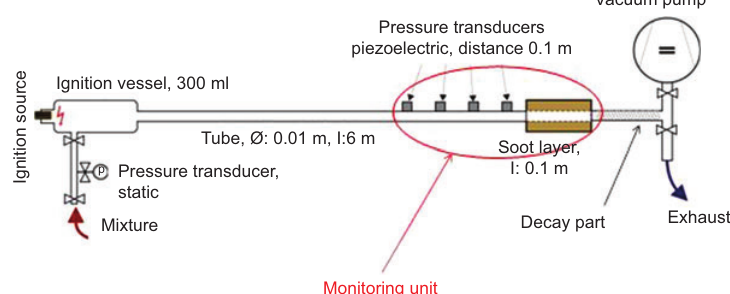
Figure 1 Schematic diagram for the ‘ determination parameter setup ’ .